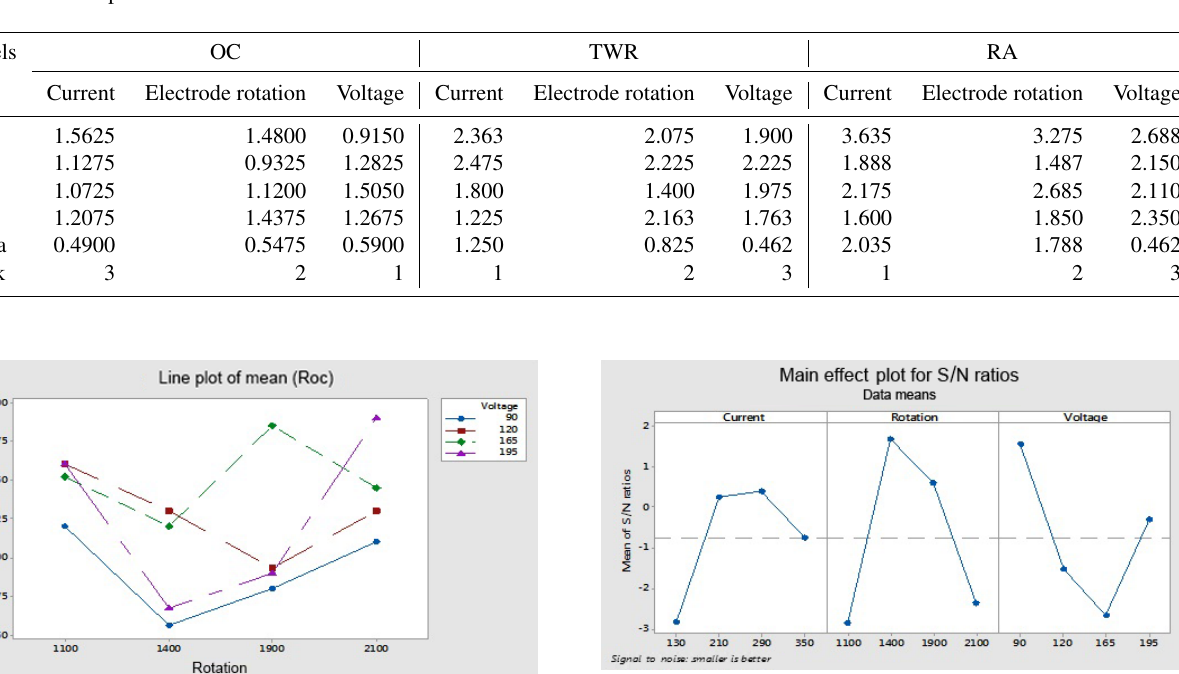
Table 8. Mean response table for untreated electrode.